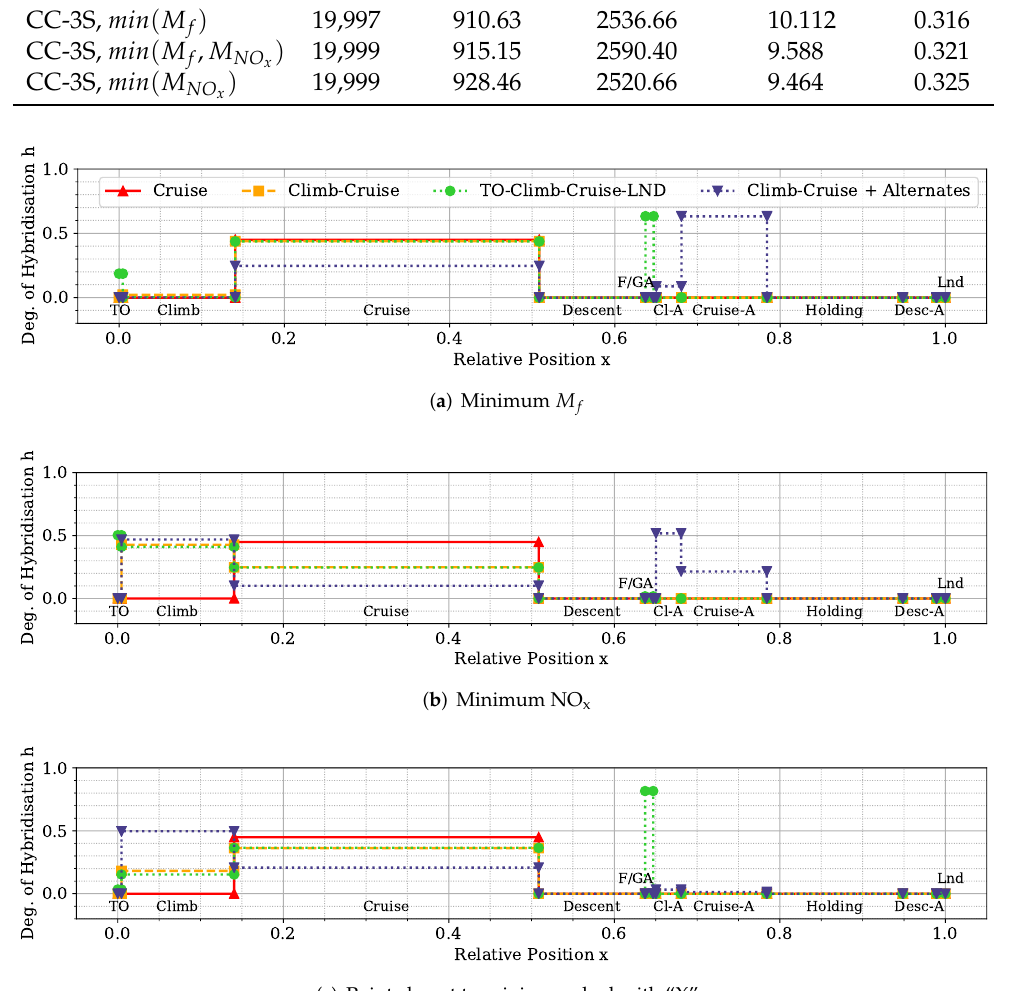
Figure A5. Optimal energy management strategies of points in Figure